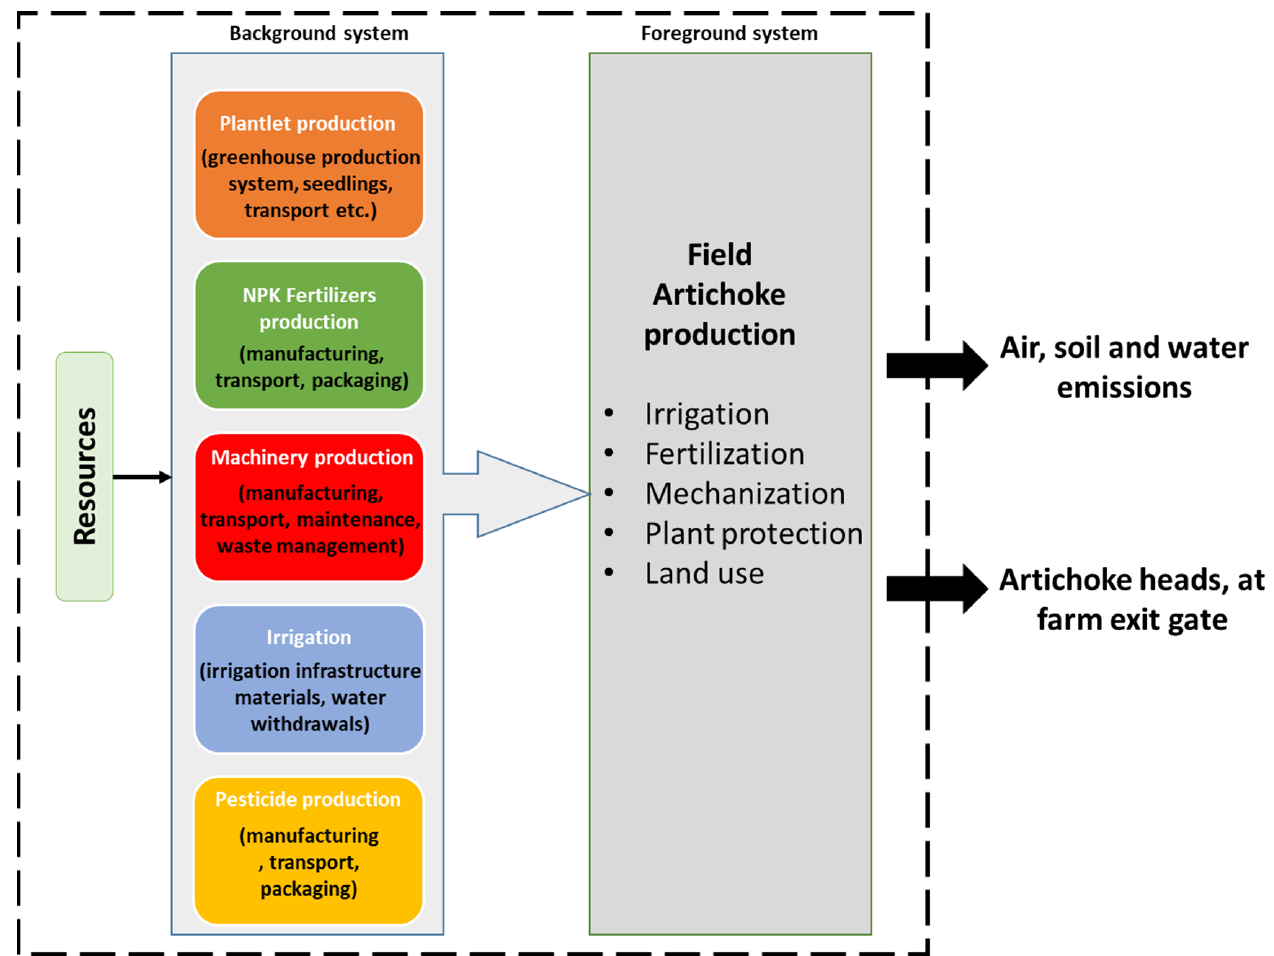
Figure 1. LCA system boundary for the globe artichoke production.